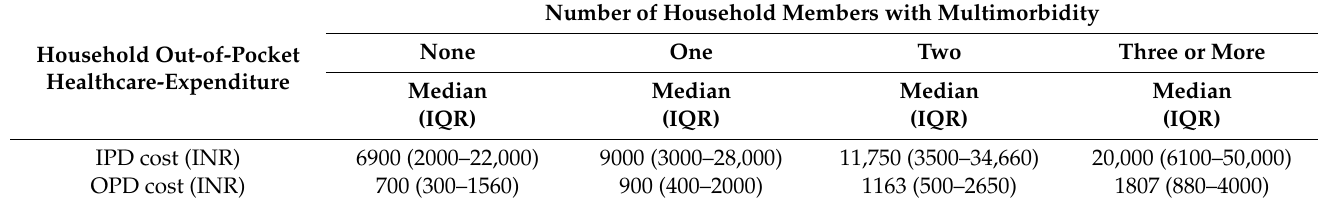
Table 5. Healthcare expenditure (in Indian national rupee) towards inpatient and outpatients